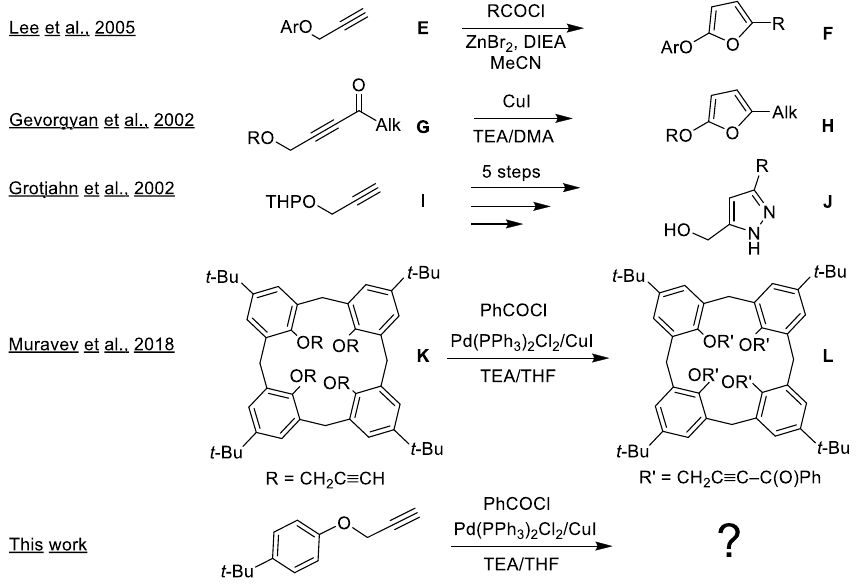
Pd(II) – Cu(I)-catalyzed reaction of heteropropargyl systems with acid chlorides. Figure 1. Some examples of biologically active and metal-coordinating pyrazoles. 3,5-disubstituted 1 Н -pyrazole derivatives can be synthesized from ketoacetylenes